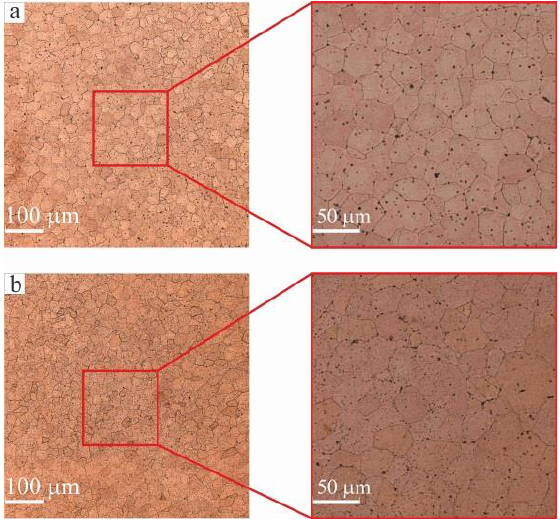
Figure 5. Optical microscopy of copper interlayers: ( a ) zone II; ( b ) zone IV. Copper interlayers have only equiaxed grains with an average size of 28.5 ± 0.2 μm.